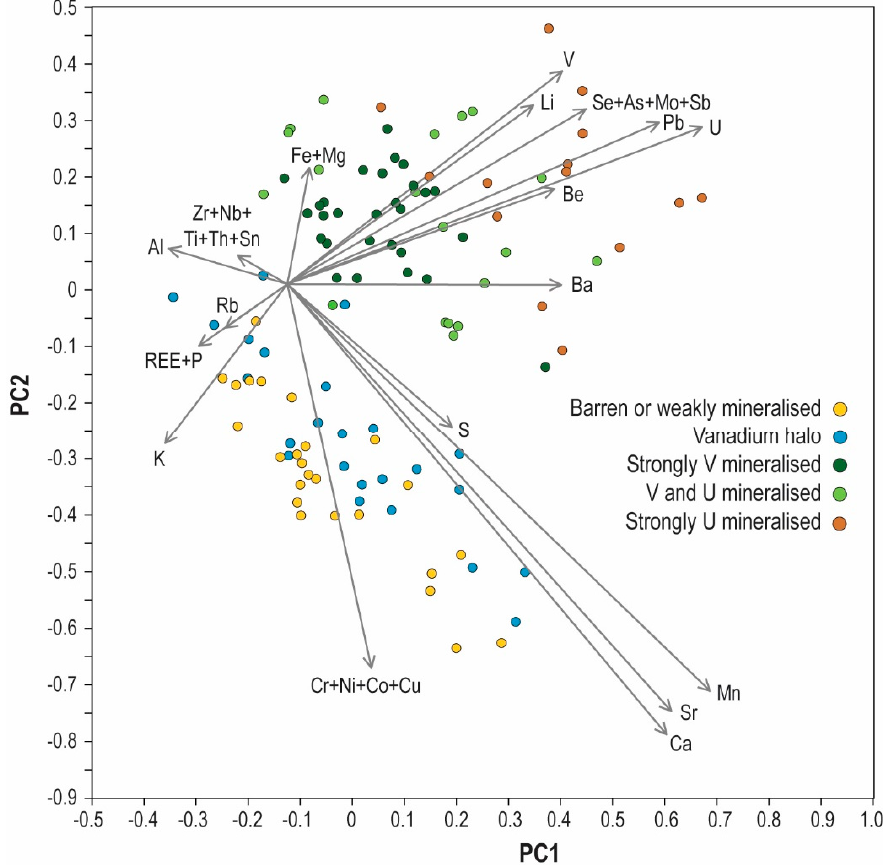
Figure 13. Principal Component Analysis vector plot for the Bigrlyi multi-element geochemical dataset categorized by mineralization type (see text for further details). The length of the PCA vectors is proportional to the variability of the principal components, and the direction of the vector and its proximity to the sample points indicates how heavily the sample position is influenced by that variable.